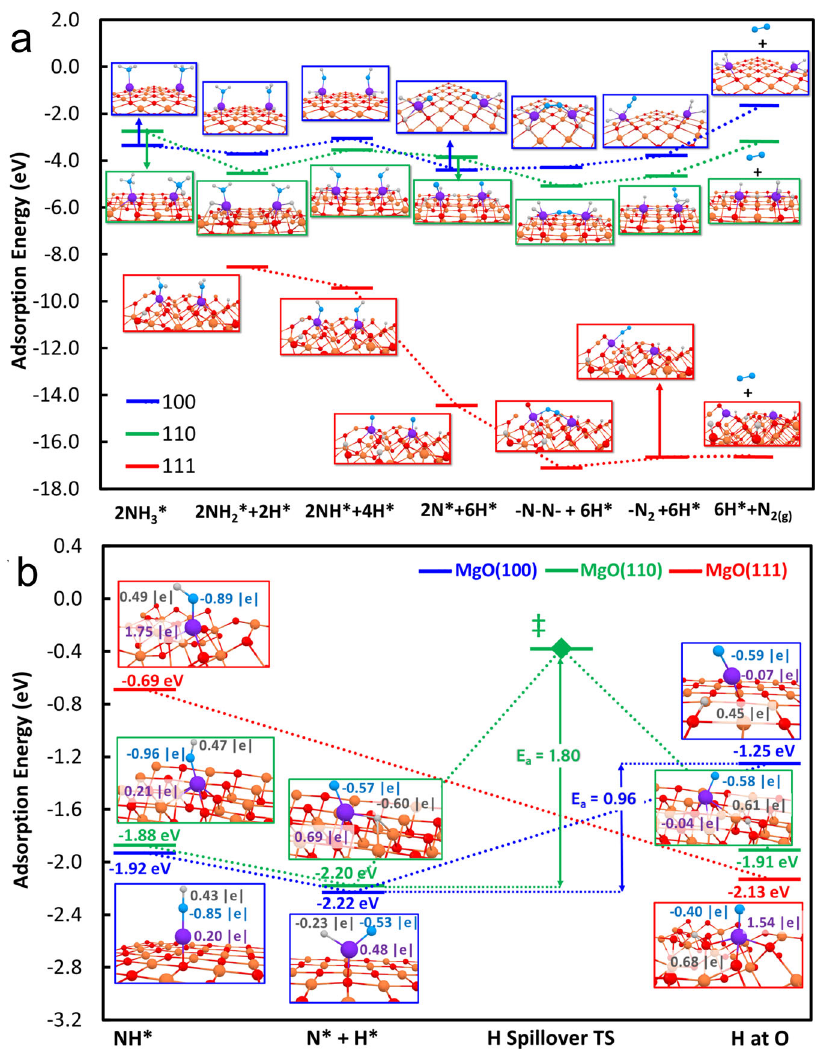
Fig. 6 | DFT calculations of Ru/MgO(100), Ru/MgO(110) and Ru/MgO(111). Energy pro fi les and their corresponding optimized intermediate structures for ( a ) ammonia decomposition and N – N recombination pathways to form N 2 at MgO- supported two Ru single atoms and ( b ) hydrogen removal from NH* species and hydrogen spillover at MgO-supported Ru single atom. The reactions were calcu- lated over (100), (110) and (111) facet of MgO shown in blue, green and red lines, respectively. E a (in eV) refers to the activation energies of hydrogen spillover from